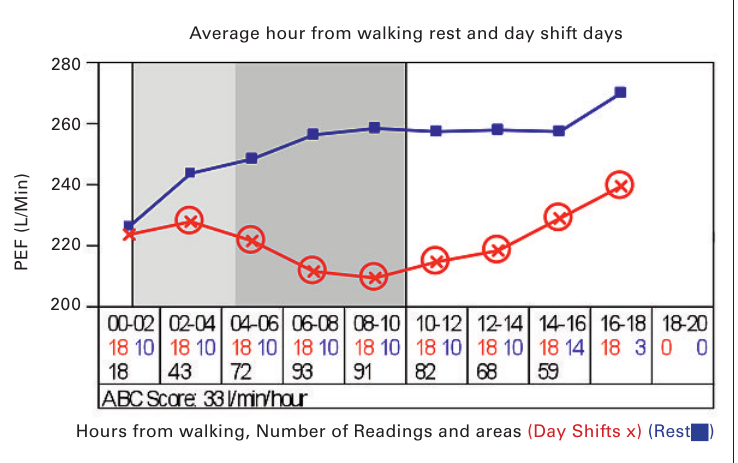
Plot of mean 2-hourly PEF expressed as hours from waking from the same record in the plastic moulder shown in fig. 1.The top line shows the mean PEF on days away from work and the lower line the mean values for workdays.The shaded areas show the times worked, the darker section shows the modal time of starting and stopping work, the paler area the earliest time of starting work. Below the times are the numbers of readings contributing to each timepoint, and below that the mean difference between the work and restday value for each period.The ABC score (Area Between Curves) is 33 L/min/hour. Values over 15 L/min/hour indicate occupational asthma.The circled work timepoints show those outside the 95% confidence intervals for days away from work. 8/9 are positive, if >1 is positive occupational asthma is likely. All three scores in this worker show an occupational effect, giving a specificity of 100% and a sensitivity of 56%. If only one of the three measures was positive the sensitivity would be 89% and specificity 80%. He had a positive specific challenge test to